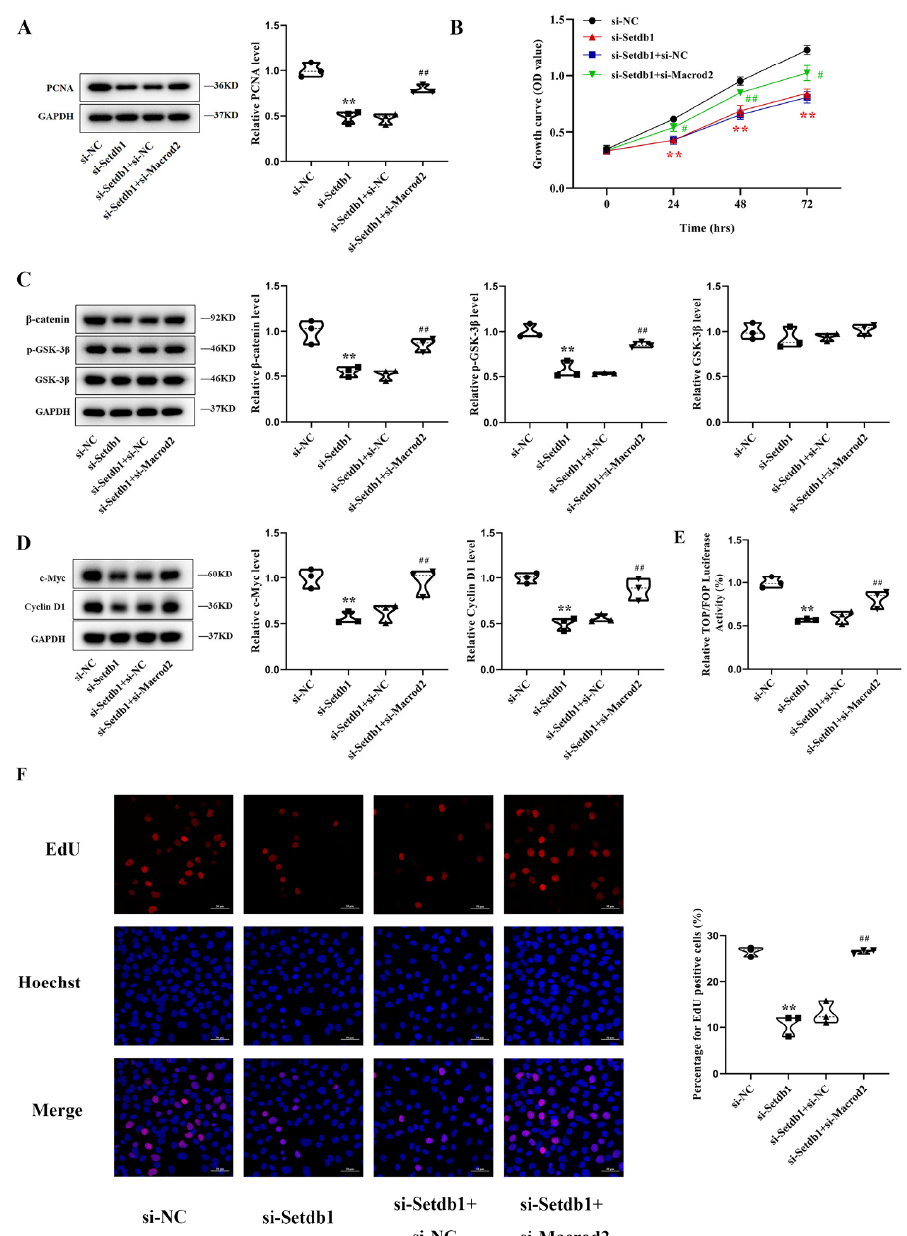
Figure 5. The knockdown of Macrod2 attenuates the inhibitory effect of Setdb1 knockdown on osteoblast proliferation in MC3T3-E1 cells. ( A ) Protein expression of PCNA in MC3T3-E1 cells by Western blotting after MC3T3-E1 cells cotransfected with si-Setdb1 alone or si-Setdb1 plus si-Macrod2 ( n = 3). One-way ANOVA followed by LSD’s multiple comparisons test. ( B ) Cell proliferation as evaluated by a CCK-8 assay in MC3T3-E1 cells in the indicated groups ( n = 3). Repeated measures ANOVA. ( C ) Western blotting analysis of β -catenin, p-GSK-3 β , and GSK-3 β in MC3T3-E1 cells ( n = 3). One-way ANOVA followed by LSD’s multiple comparisons test. ( D ) Western blotting analysis for c-Myc and Cyclin D1 protein levels in MC3T3-E1 cells ( n = 3). One-way ANOVA followed by LSD’s multiple comparisons test. ( E ) Measurement of TOP/FOP reporter activity in MC3T3-E1 cells ( n = 3). One-way ANOVA followed by LSD’s multiple comparisons test. ( F ) The EdU labeling assays in MC3T3-E1 cells from each group ( n = 3). Scale bar, 50 µ m. One-way ANOVA followed by LSD’s multiple comparisons test. ** p < 0.01 vs. the cells transfected with si-NC. # p < 0.05 vs. the cells co-transfected with si-Setdb1 and si-NC. ## p < 0.01 vs. the cells co-transfected with si-Setdb1 and si-NC.